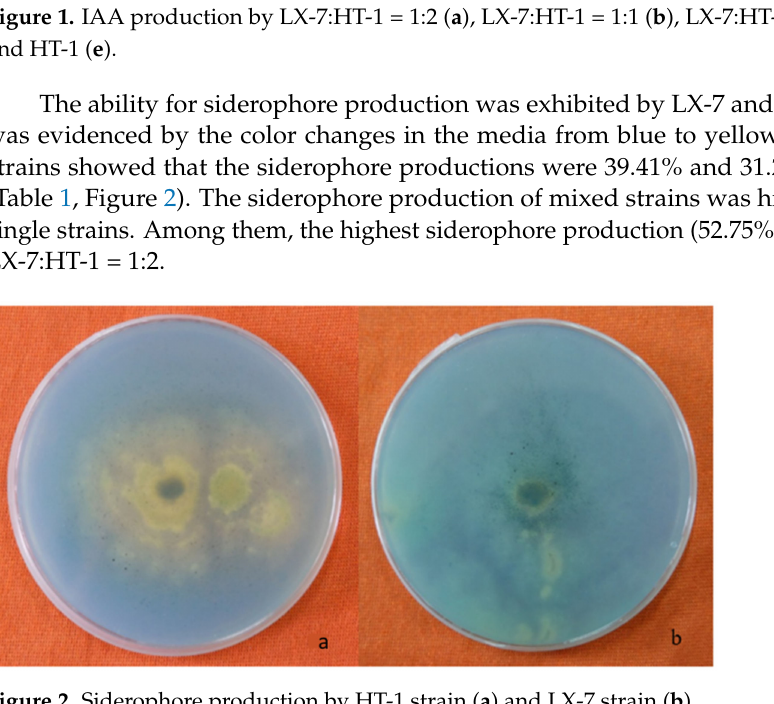
Figure 2. Siderophore production by HT-1 strain ( a ) and LX-7 strain ( b ). The presence of transparent circles on PDA medium containing organic phosphate or inorganic phosphate indicated that the strain had the ability of phosphate